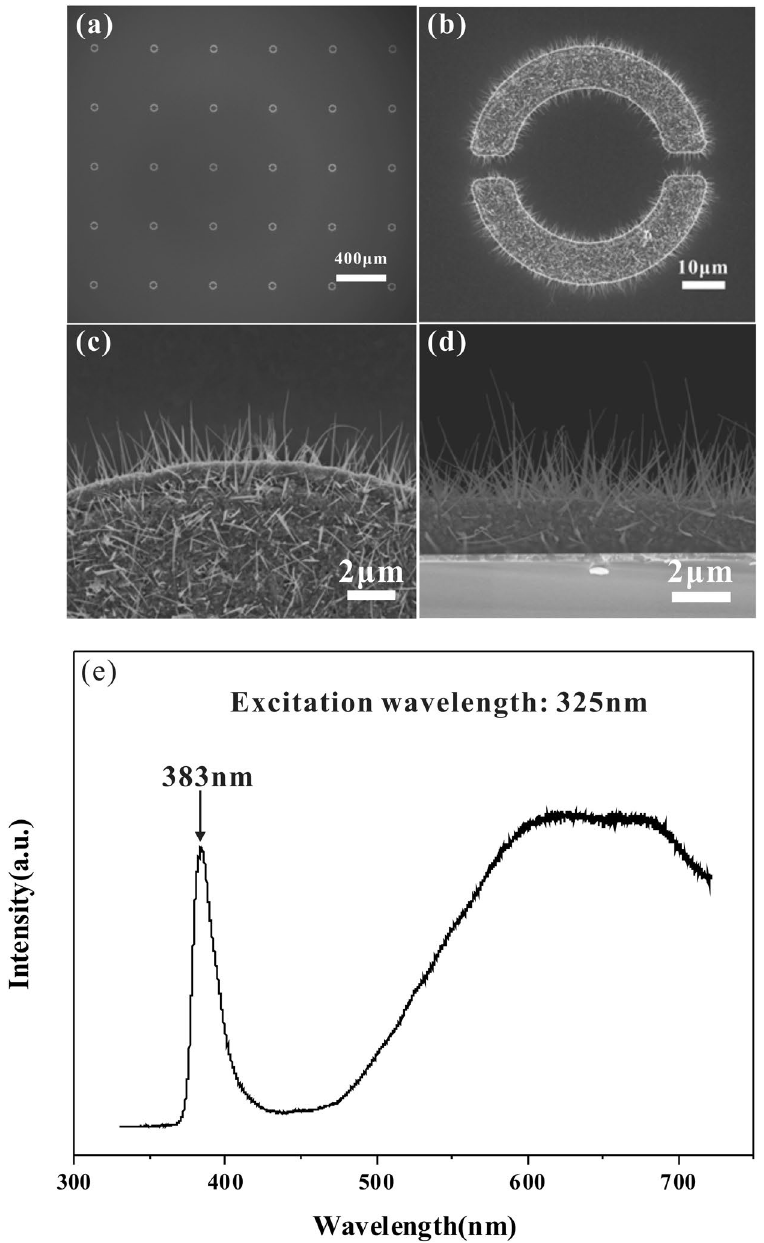
Figure 2. ( a ) Top-view SEM images of the ZnO nanowire pads in the array; ( b ) morphology of ZnO nanowires grown from a single Zn thin film pad; ( c ) amplified SEM image of the local region of a half-ring structure in a single ZnO film pad; ( d ) cross-sectional SEM image of the ZnO nanowire pad; ( e ) room-temperature PL spectrum of the ZnO nanowire pad in the